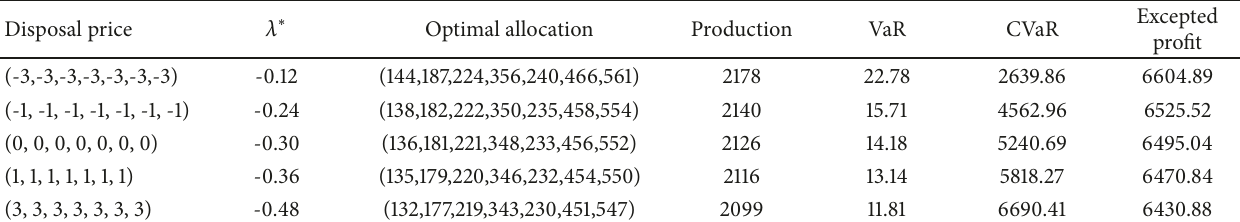
Table 2: Allocation, VaR, CVaR, and t he excepted profit of chain stores in the centralized supply ( 𝜆 ∗ ). Disposal price 𝜆 ∗ Optimal allocation